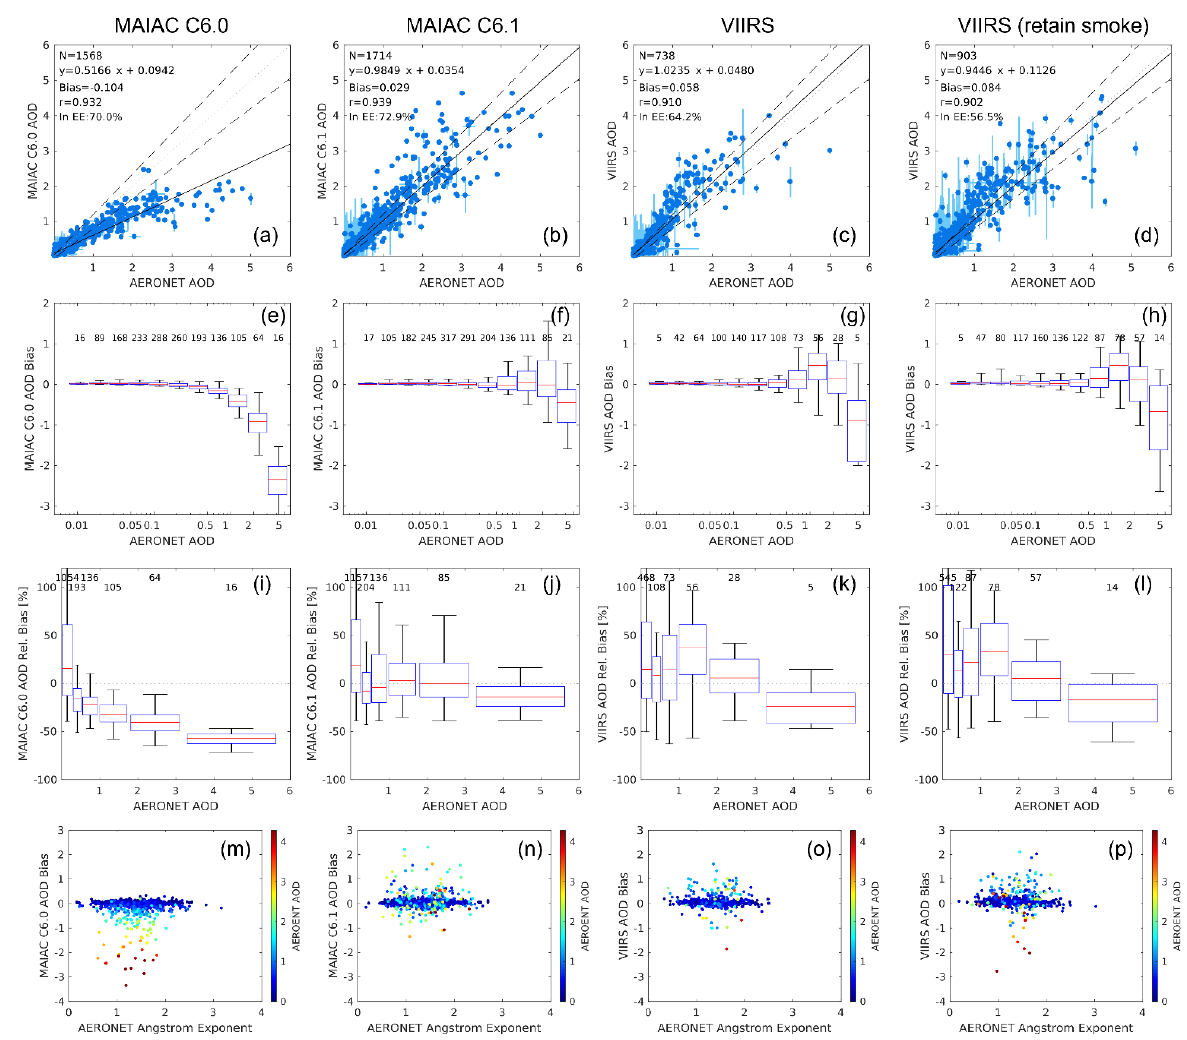
Figure 2. Comparison of three satellite AOD products of MODIS MAIAC C6.0, MAIAC C6.1, and VIIRS (best-quality and retaining all-quality retrievals passing the internal heavy aerosol test with AOD > 0.5) against AERONET measurements over the western U.S. in September 2020. ( a – d ) Scatter plots comparing the AOD (550 nm) retrievals. The horizontal and vertical bars represent the ±1σ variability in the corresponding space and time window for each satellite-AERONET matchup. The grey dotted line represents the 1:1 line. Statistical measures of the validation are noted within each plot. The black dashed lines are the error envelope (EE) of ±(0.05 + 15% AOD). ( e – h ) Box-whisker plots of the satellite AOD retrieval bias as a function of AERONET AOD (shown for 11 bins). The bin sizes are set in logarithmic scale. For each AOD bin, the red line represents the median, the upper and lower bounds of the box are the 75th and 25th percentiles, and the ends of vertical lines are the 5th and 95th percentiles. The number of matchups in each bin is noted at the top. ( i – l ) Similar as ( e – h ) but for relative bias (%). The bin setting follows ( e – h ) but the lower six bins are merged (0 – 0.29). ( m – p ) Scatter plots of the satellite AOD bias as a function of Å ngström Exponent (440 – 675 nm) measured at the AERONET sites. Data are color coded by the AERONET AOD.